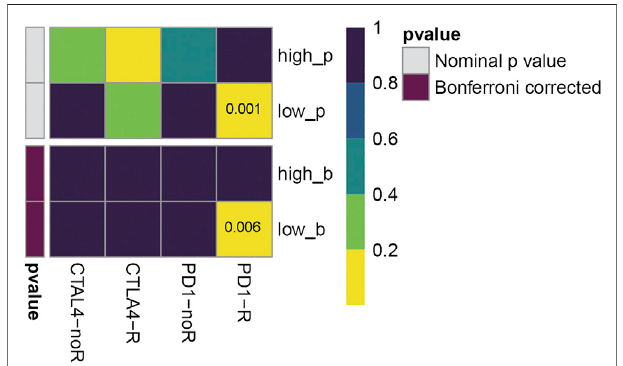
FIGURE 9 | Effect prediction of immunotherapy response in TCGA cohort. The horizontal axis shows the groups placed on CTLA-4 and PD-1 immunotherapies. PD1-R, patients respond to PD-1 therapy, PD1-noR, patients do not respond to PD-1 therapy. The vertical axis shows the high/low-risk groups classi fi ed by fi ve-gene prognostic signature, p refers to nominal p -value, b refers to Bonferroni-corrected p -value. The color represents the signi fi cance levels ( p